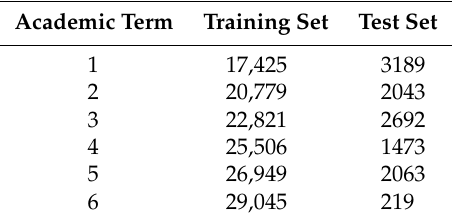
Table 2. The size of training sets and test